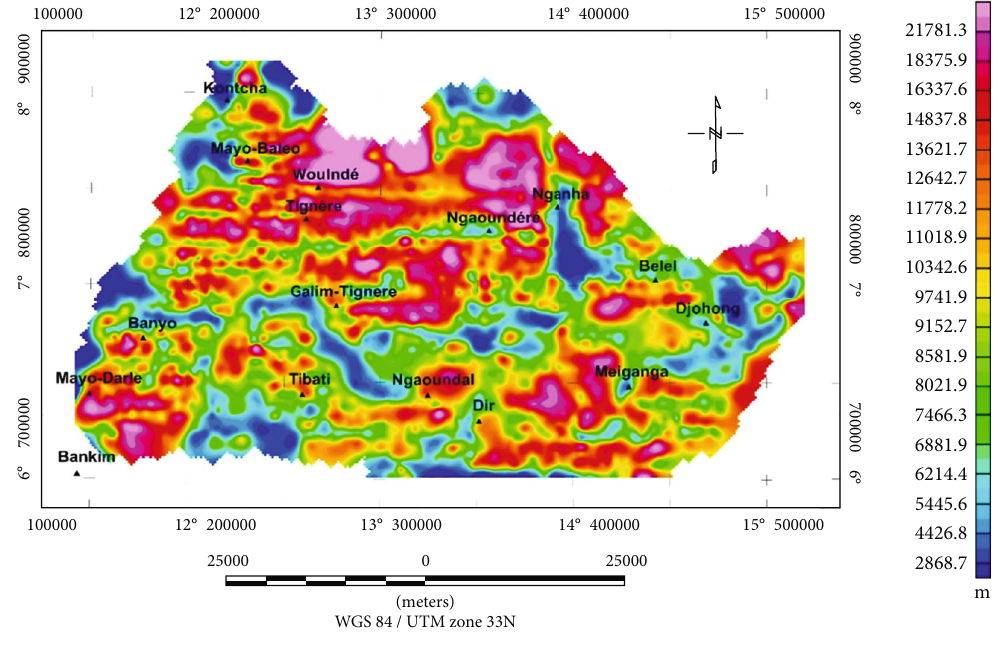
Figure 7: Depth determination from source parameter imaging